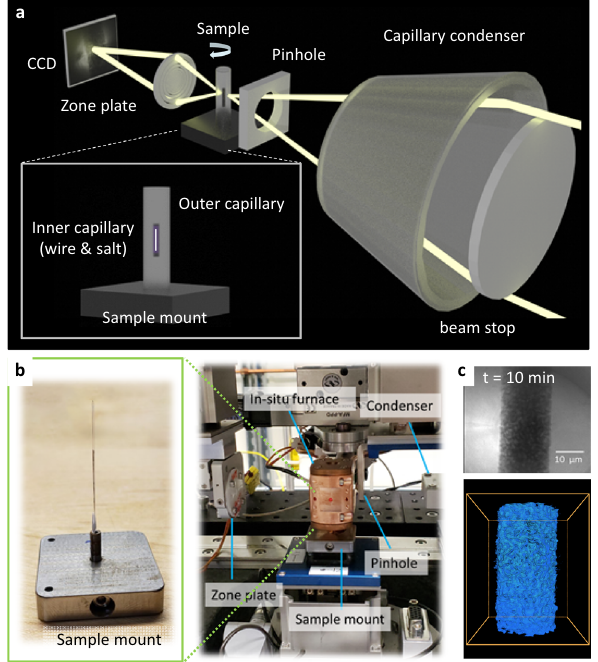
Fig. 1 In situ X-ray nano-tomography experiment to directly visualize the dealloying process in Ni – 20Cr alloy in molten KCl – MgCl 2 at 800 °C. a A schematic showing the optical scheme of transmission X-ray microscopy (TXM) and a double-capillary sample design used for the experiment. b Photographs taken at the NSLS-II FXI beamline, 18-ID, NSLS-II showing the experimental setup, and c a representative TXM projection image (darker means higher X-ray attenuation) and reconstructed 3D volume rendering (the bounding box dimension is 36.8 × 36.8 × 45.5 μ m 3 ) of the microwire after a 10-min reaction, showing the progression of